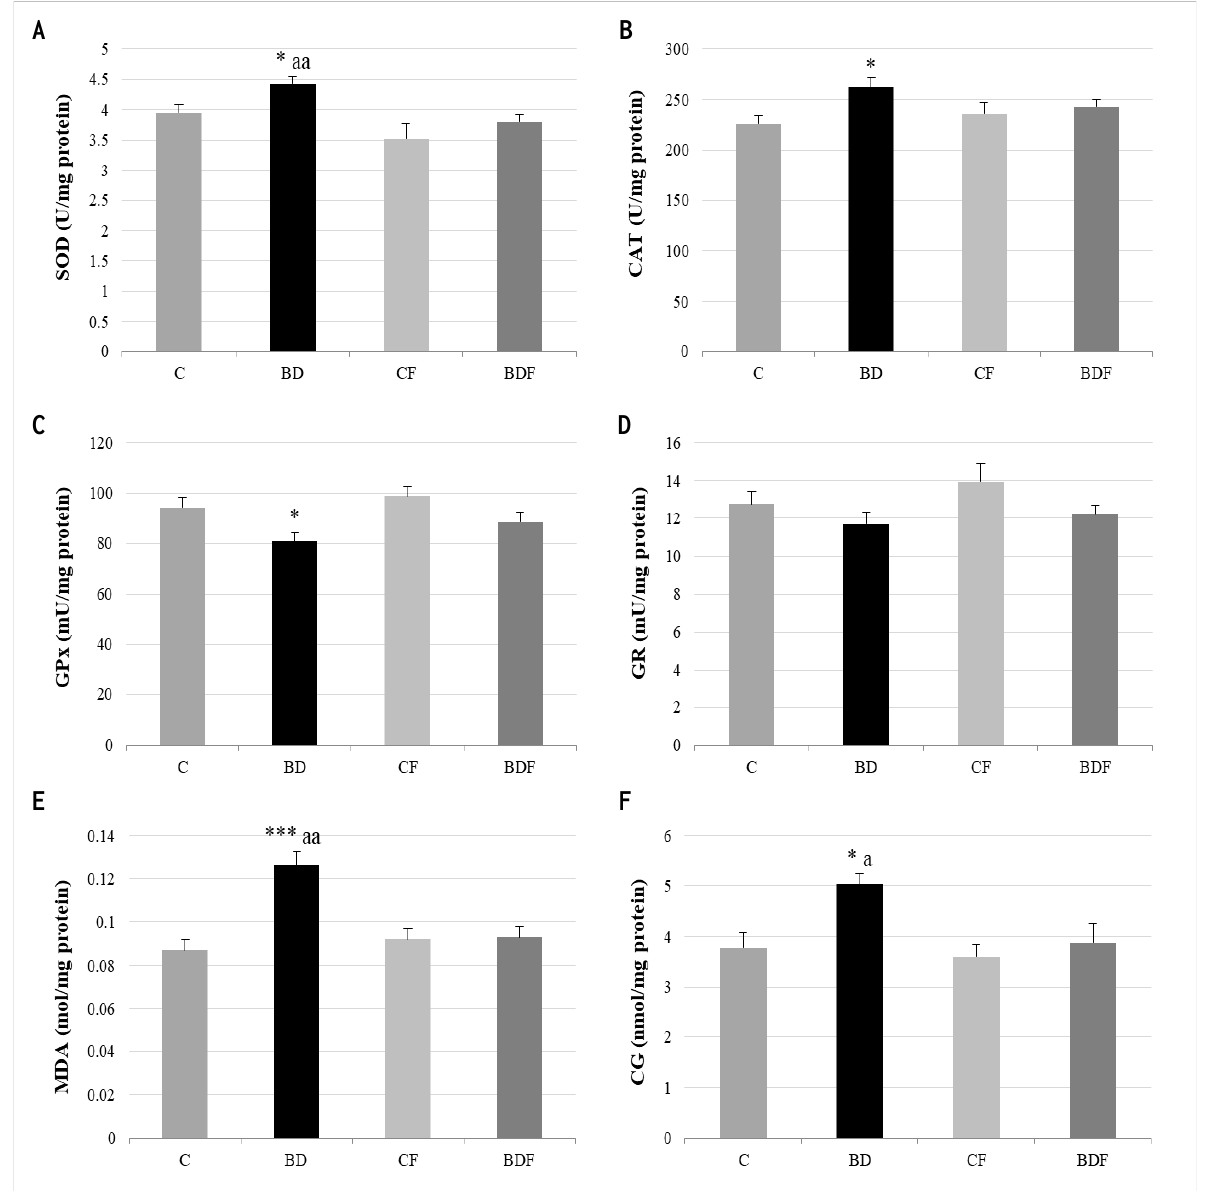
Figure 2. Hepatic oxidative balance: activity of antioxidant enzymes and oxidative stress markers. Superoxide dismutase (SOD) ( A ), catalase (CAT) ( B ), glutathione peroxidase (GPx) ( C ), glutathione reductase (GR) ( D ), lipid oxidation expressed by the levels of malondialdehyde (MDA) ( E ) and protein oxidation expressed by the levels of carbonyl groups (CG) ( F ). The results are expressed as mean ± SEM and analysed by a multifactorial one-way ANOVA followed by Tukey’s test. The number of animals in each group is 6 and n = 12. SEM: standard error of the mean. Groups: C: control group, BD: binge drinking group, CF: control folic group, BDF: binge drinking folic group. Signification: C vs. BD: * p < 0.05, *** p < 0.001; BD vs. BDF: a p < 0.05; aa p < 0.01.